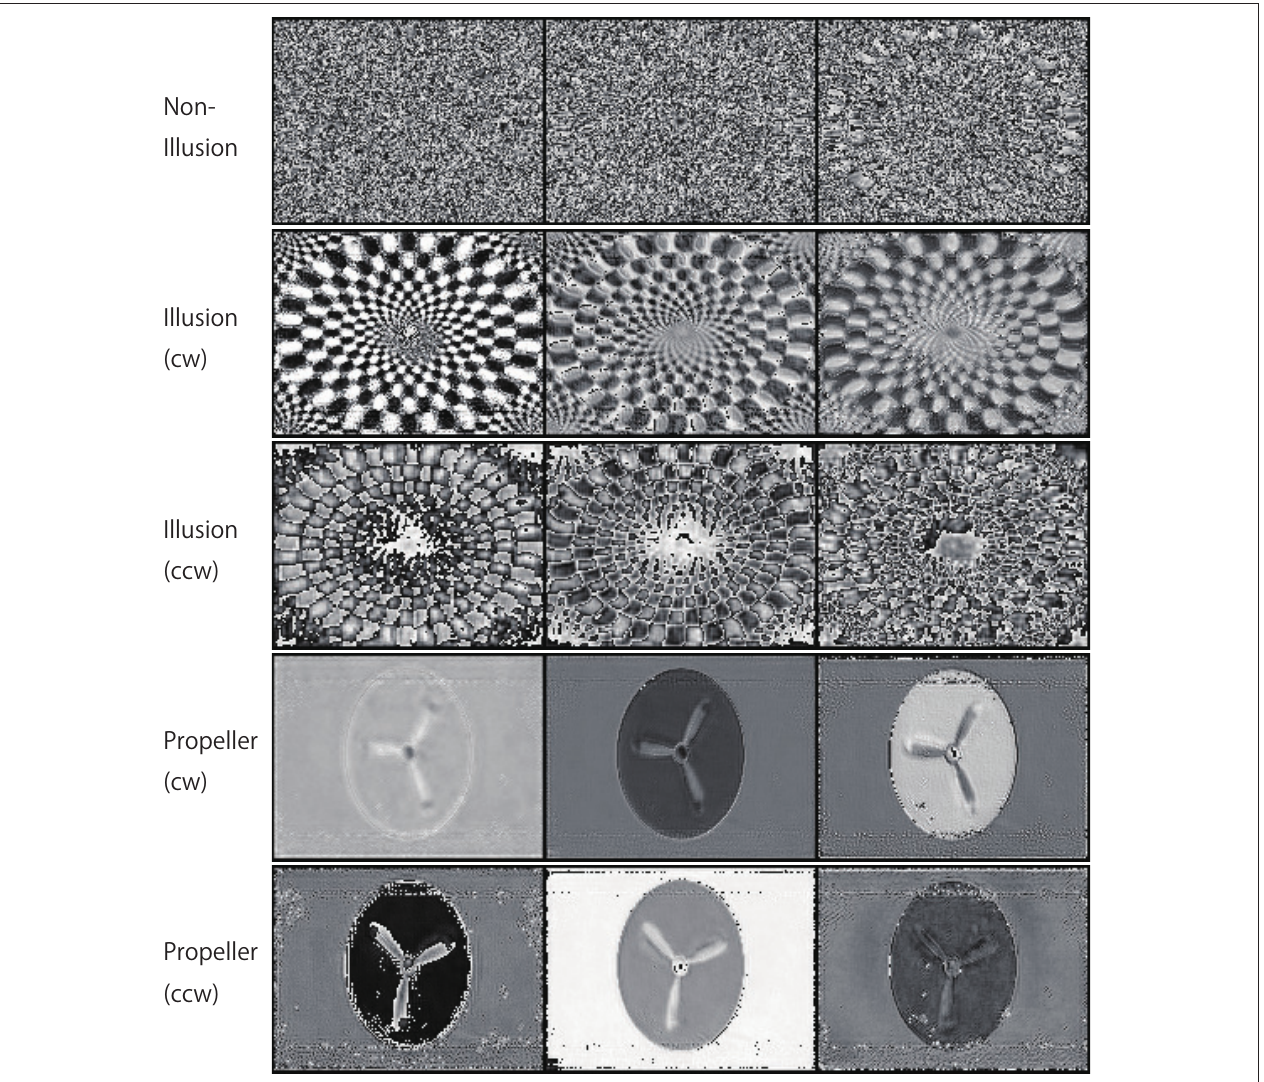
FIGURE 11 | Activation patterns of the hidden units of DNNs can be visualized (a lower layer). Samples of the activation patterns of receptive fields in a lower convolution LSTM layer are presented (R-Layer0/ConvLSTM/Variable_1_3_120_160_float32_29, refer to image data numbers of TensorBoard). A network trained with 500K video frames was used for prediction. Twenty consecutive images were input to the trained networks, and visualization was then performed using TensorBoard. In this layer, there are three channels with a 120 (width) × 160 (height) pixel image. In the cw illusion, horizontal inversion pictures of the single-ring illusion (ccw) presented in Figure 2 were used as input pictures. Note that noisy random patterns are specifically observed in